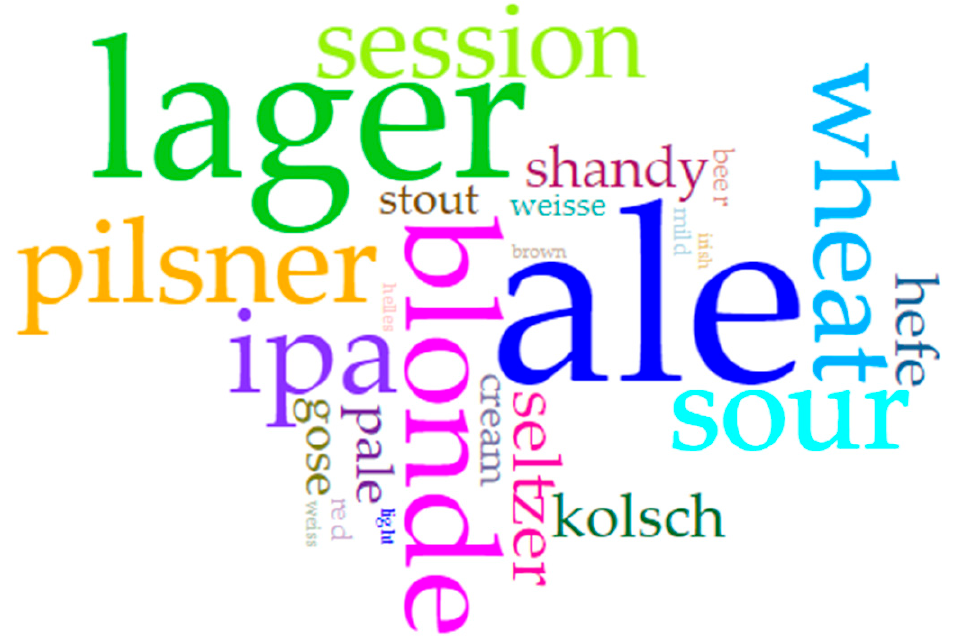
Figure 4. Word cloud (larger text indicates higher frequency of use) visualizing the frequency of words in breweries’ descriptions of their low(er) alcohol offerings (Data from the authors; visualization via Voyant: https://voyant-tools.org/?corpus=aef5201d283dc3b70ed5289ab57d42e2; accessed on 3 October